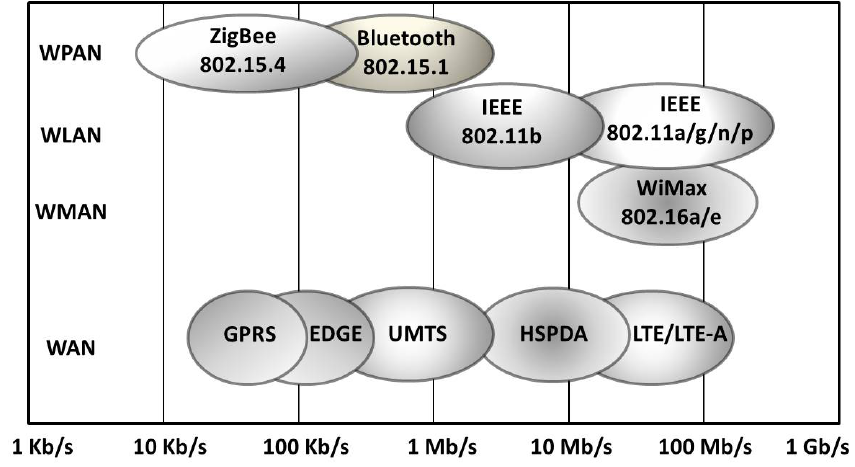
Figure 1. Vehicular-related wireless technologies comparison (adapted from